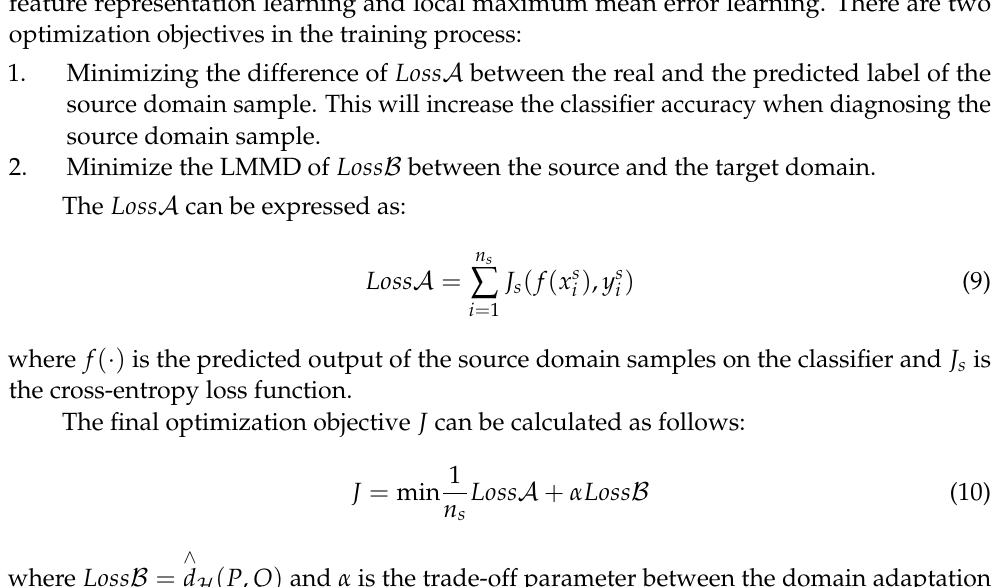
Table 1. Details of the CWRU dataset.